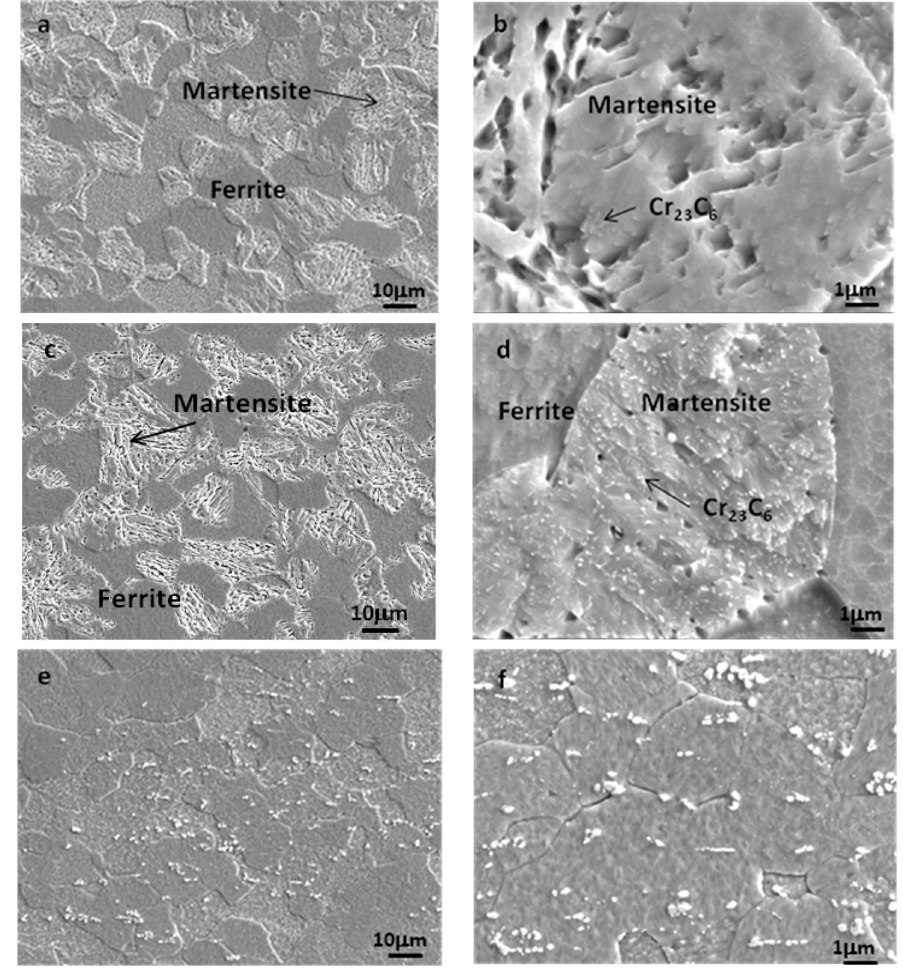
Figure 6. Scanning electron microscopy (SEM) micrographs of the ferrite/martensite complex structure ( a , b ) by quenching and partitioning (Q-P) treatment, ( c , d ) by quenching and tempering (Q-T) treatment, and ( e , f ) by annealing treatment.